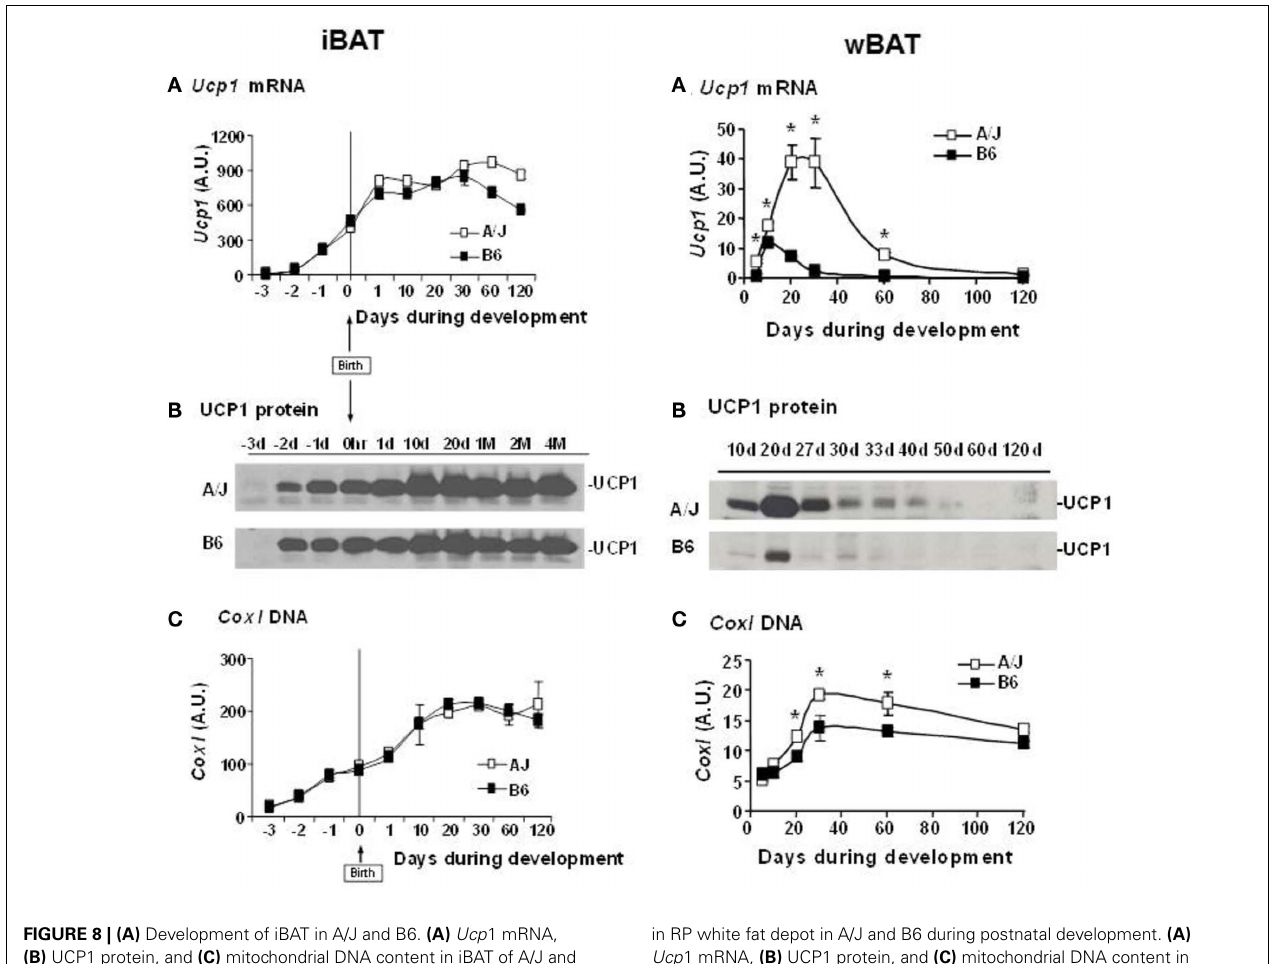
FIGURE 8 | (A) Development of iBAT in A/J and B6. (A) Ucp 1 mRNA, (B) UCP1 protein, and (C) mitochondrial DNA content in iBAT of A/J and B6 mice during perinatal and postnatal development. For Ucp 1 mRNA, each time point gives the average value from 4 to 9 individual animals analyzed in duplicate and is expressed relative to cyclophilin. Cox 1 mitochondrial DNA levels are expressed relative to the nuclear gene Ucp 2 from the analysis of four mice in duplicate. (B) . Induction of UCP1